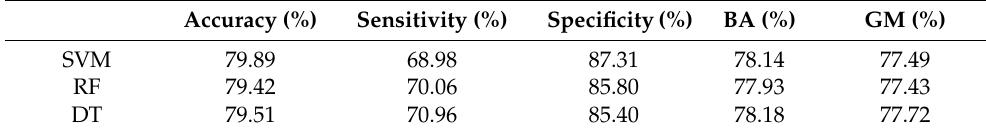
Table 1. SVM, RF, and DT classification